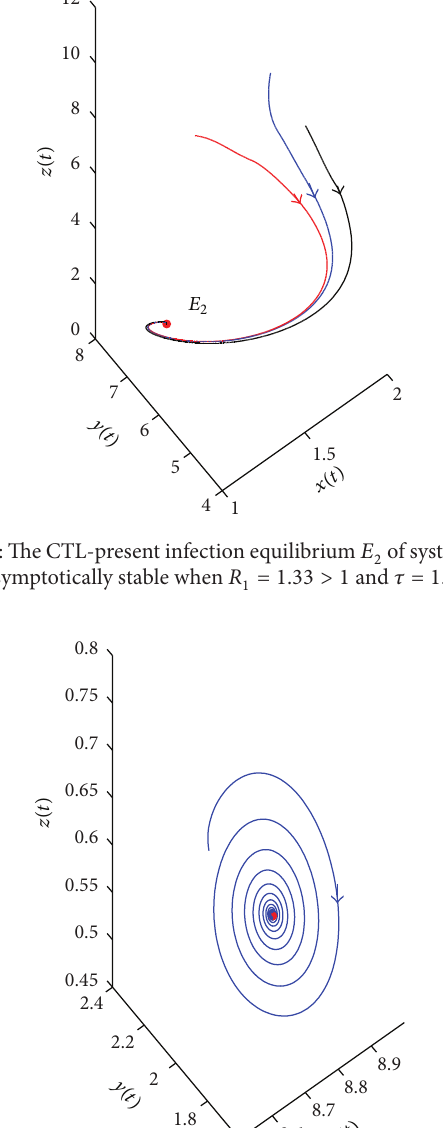
𝜔 = √𝑢 = 0.4709 . In addition, it is easy to show that 𝜏 =